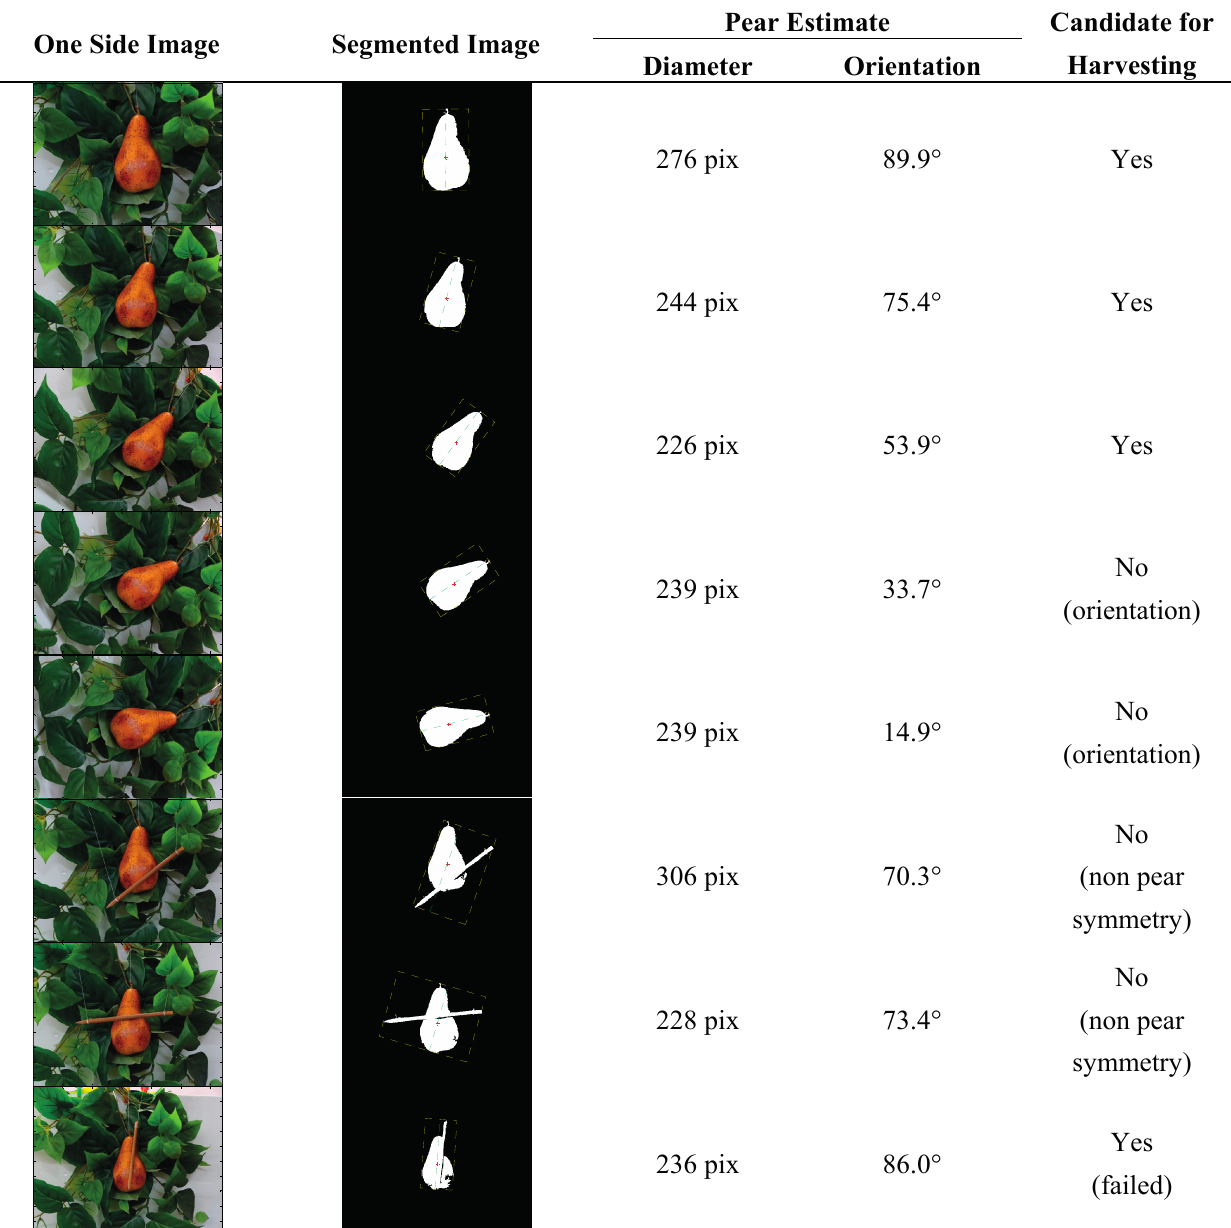
Table 8. Fruit detection: Threshold segmentation